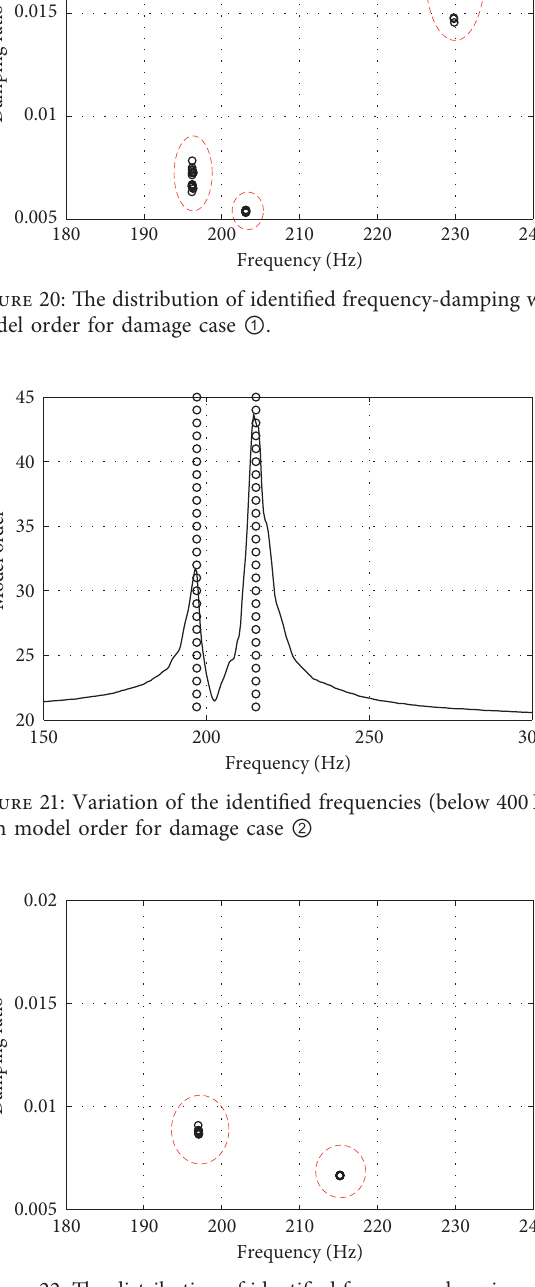
Figure 22: The distribution of identified frequency-damping with model order damage case ②